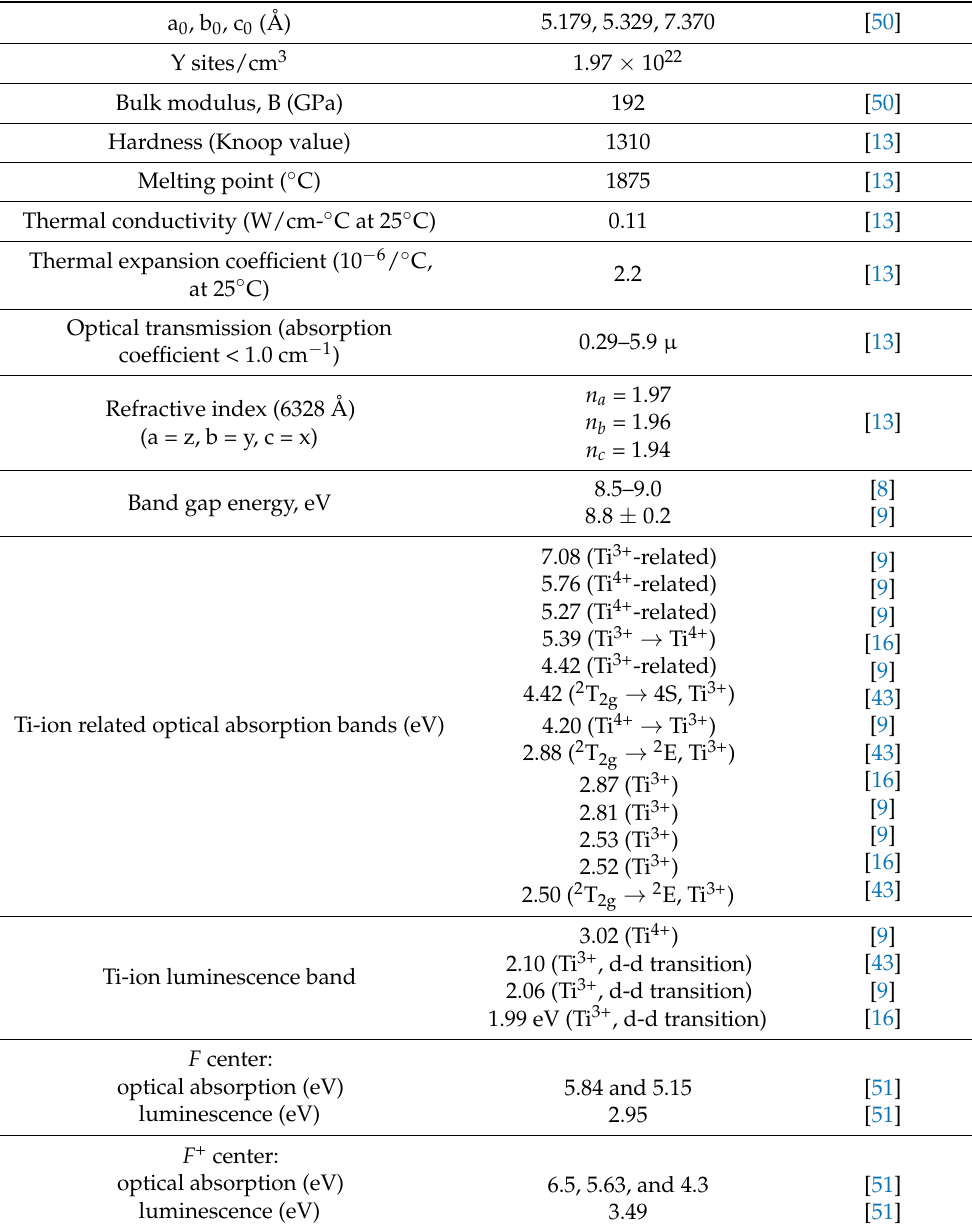
Table 1. Structural and optical properties of orthorhombic YAP and